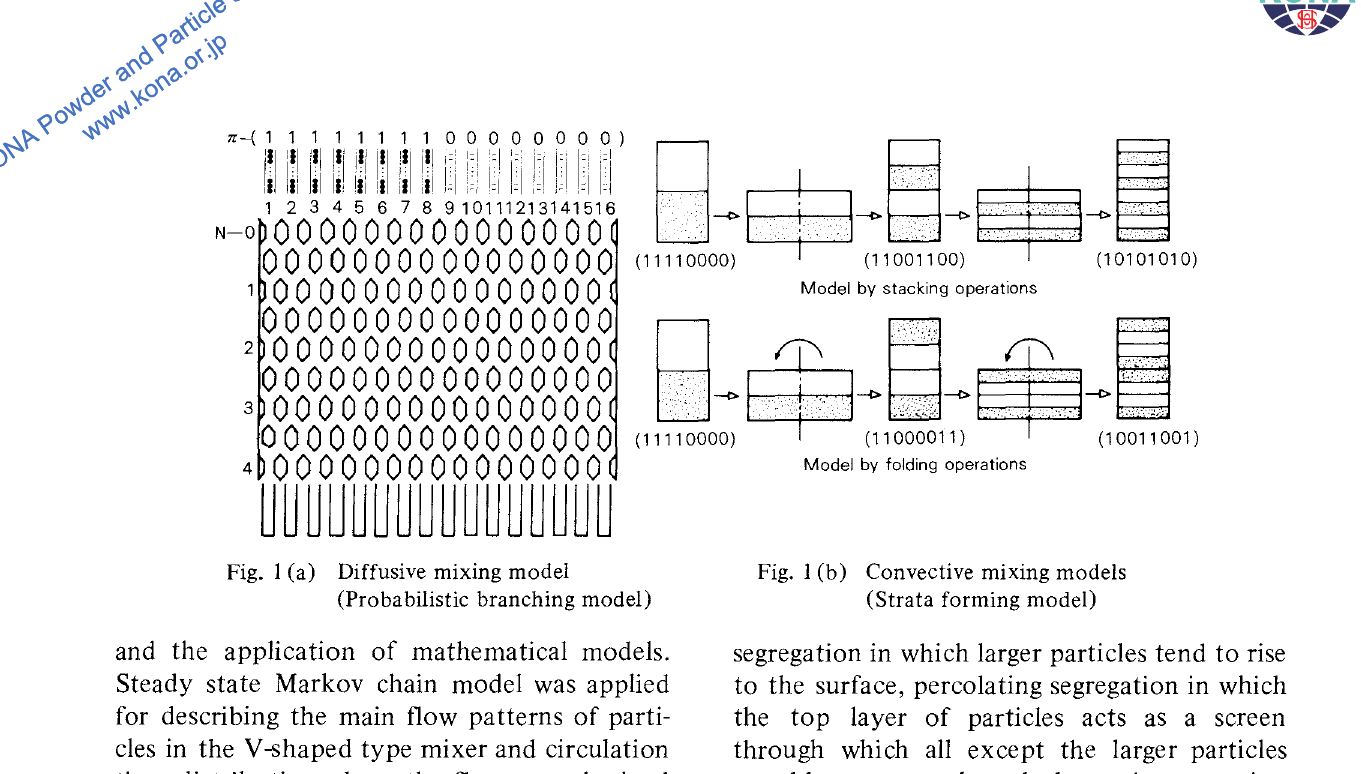
Fig. 1 (a) Diffusive mixing model (Probabilistic branching model)